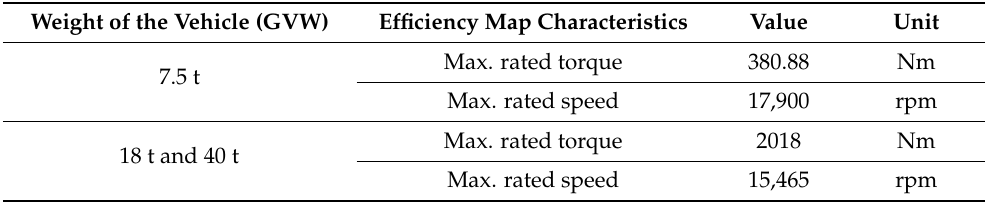
Table 6. Summary of the selected efficiency maps [22]. Weight of the Vehicle